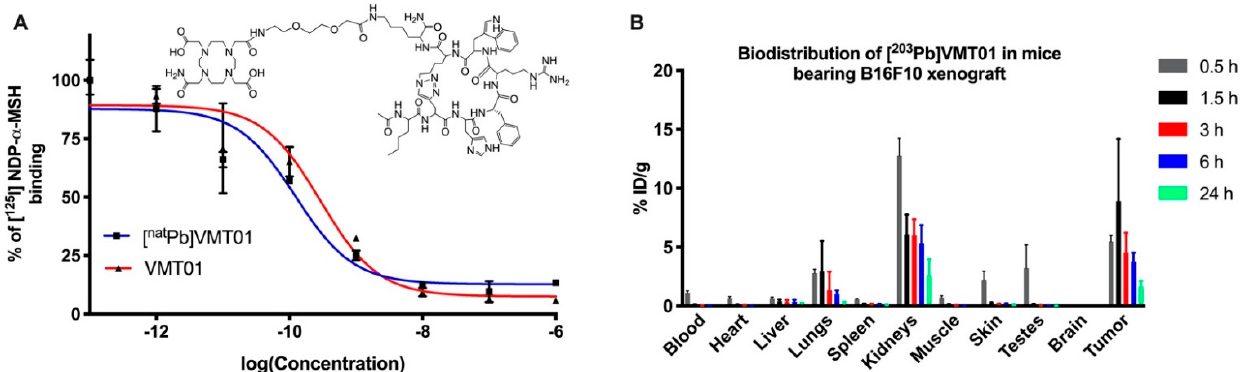
Figure 1. MC1R-targeted peptide ligand direct ionizing radiation to melanoma via binding with the receptor. ( A ) Competitive binding of VMT01 and [ nat Pb]VMT01 against [ 125 I]NDP- α -MSH in B16-F10 cells; ( B ) Biodistribution of [ 203 Pb]VMT01 in athymic nu/nu mice bearing B16-F10 melanoma ( n = 2 male and n = 2 female at each time point); Data were expressed as percent of injected dose per gram of tissue (%ID/g) ± SD. Table 1. Biodistribution of [ 203 Pb]VMT01 in B16 ‐ F10 melanoma xenograft model .